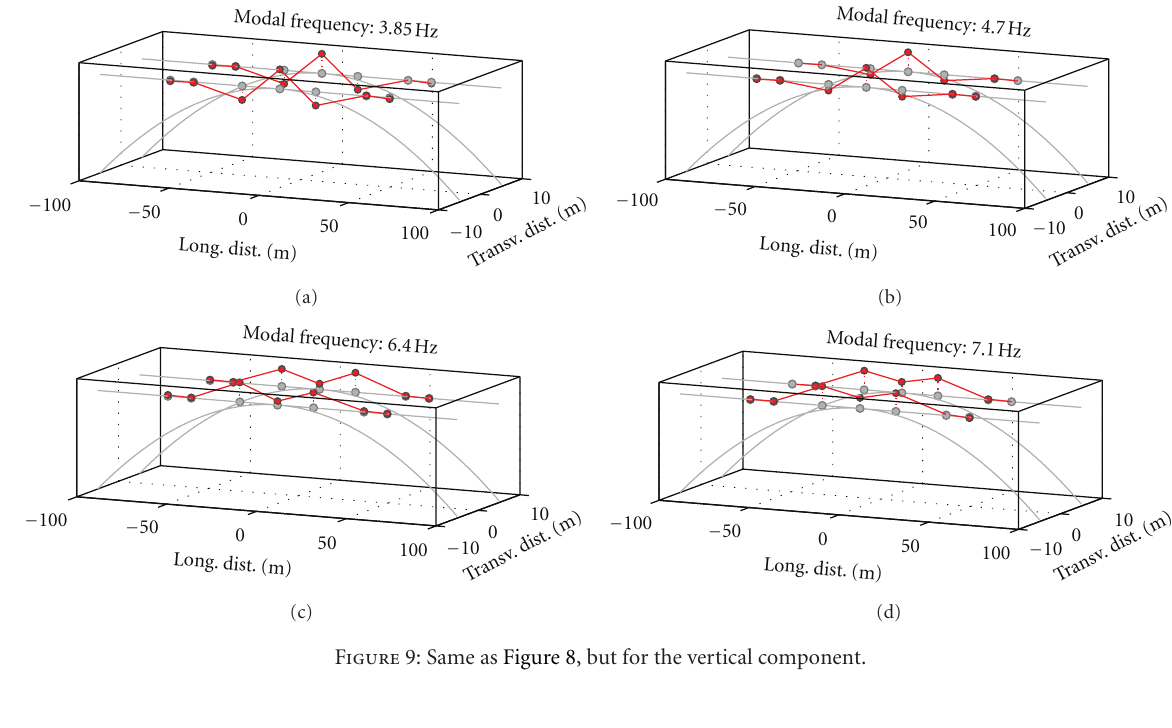
Figure 9: Same as Figure 8, but for the vertical component.